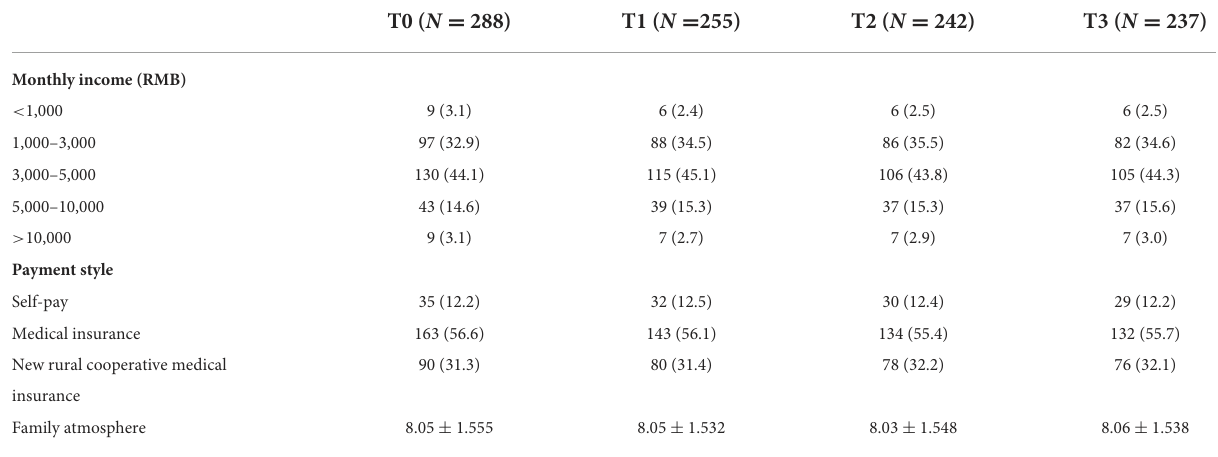
TABLE 2 Descriptions of key variables at four time points.